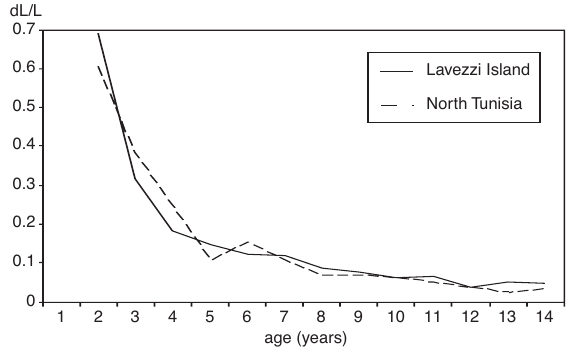
F IG . 4. – Annual evolution of the relative increase of the growth of E. marginatus from Tunisia (Chauvet, 1988) and the Lavezzi Islands (present